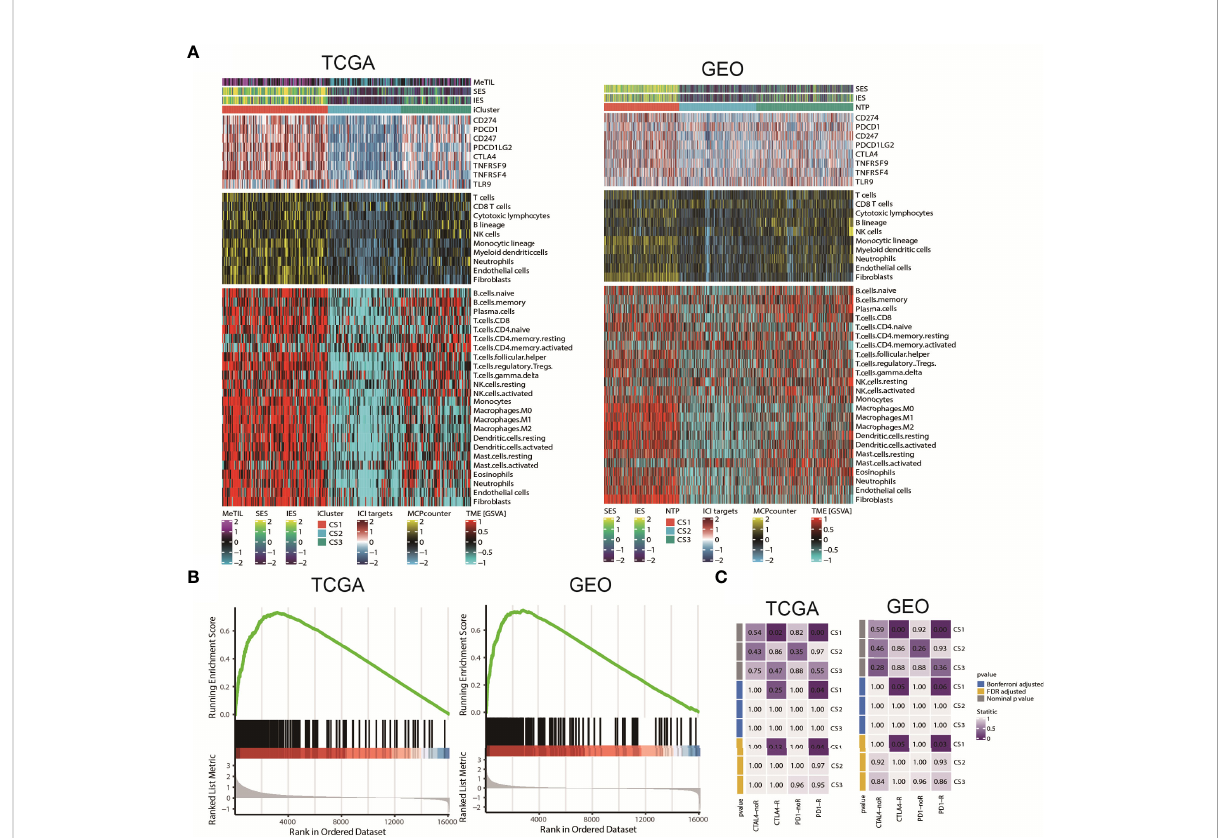
FIGURE 5 Tumour microenvironment landscape of colorectal cancer subtype. (A) Heatmap showing the immune pro fi le in the TCGA and GEO cohort, with the top panel showing the expression of genes involved in immune checkpoint targets, the middle panel showing the enrichment level of 10 microenvironment cell types using MCPcounter approach, and the bottom panel showing the 24 microenvironment cells using GSVA approach; DNA methylation of tumour-in fi ltrating lymphocytes (MeTILs) were annotated at the top of the heatmap. The immune enrichment score and stromal enrichment score were annotated at the top of the heatmap. (B) GSEA plot showing activation of interferon- g hallmark pathway. (C) Subclass analysis manifested that CS1 subtypes could be more sensitive to the immune checkpoint